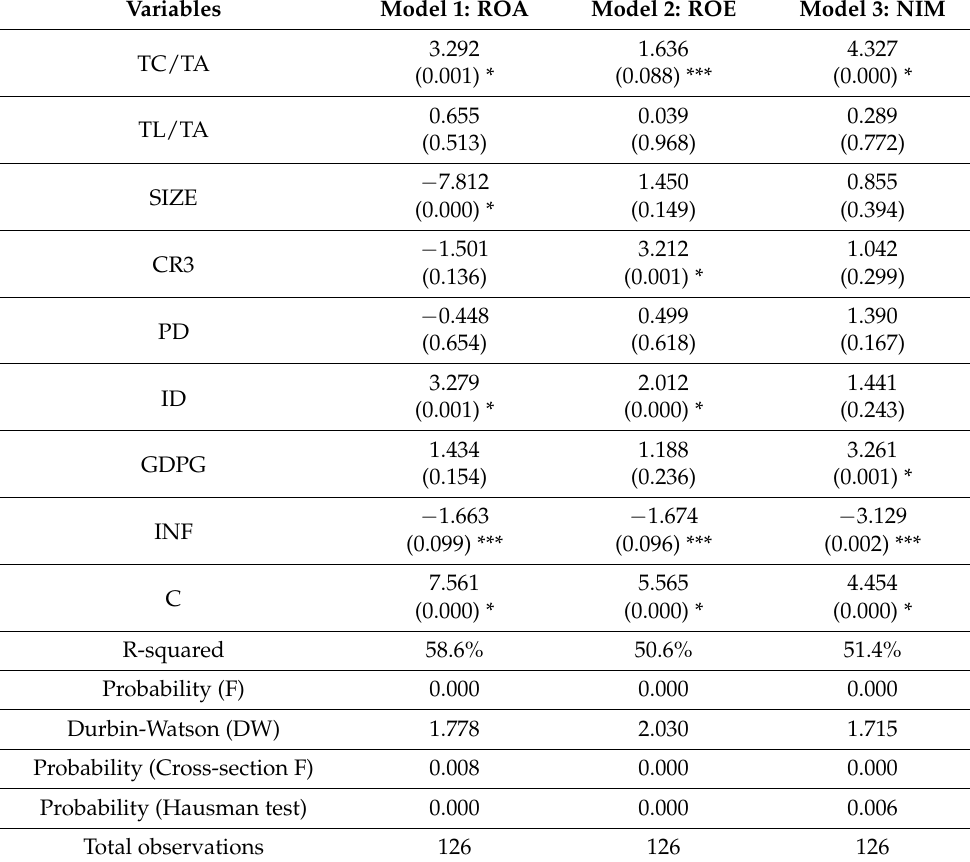
Table 3. Estimation results of the panel regression